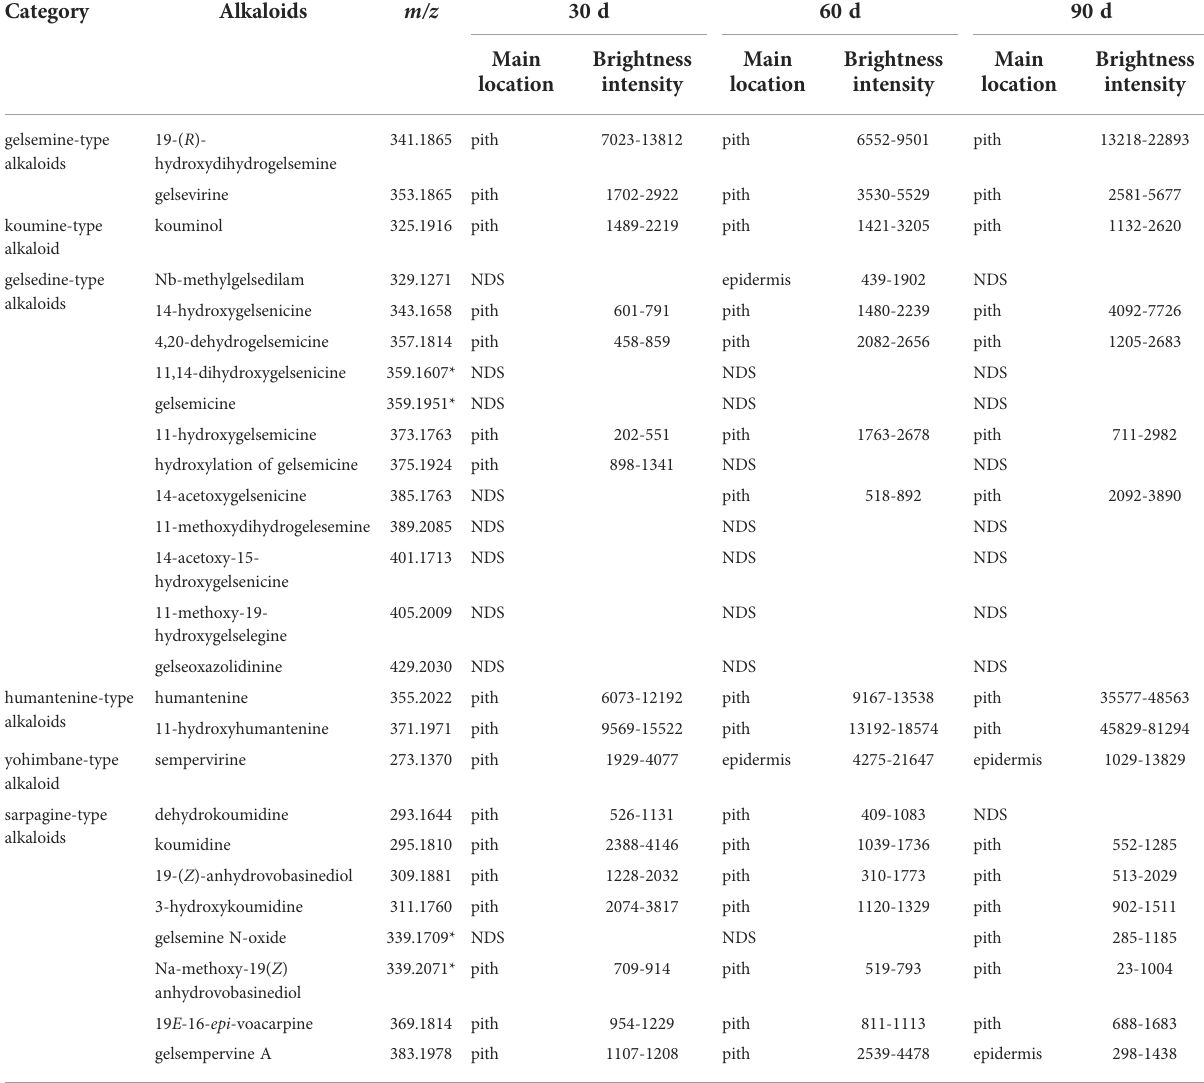
TABLE 2 Distribution of alkaloids in seedling roots.